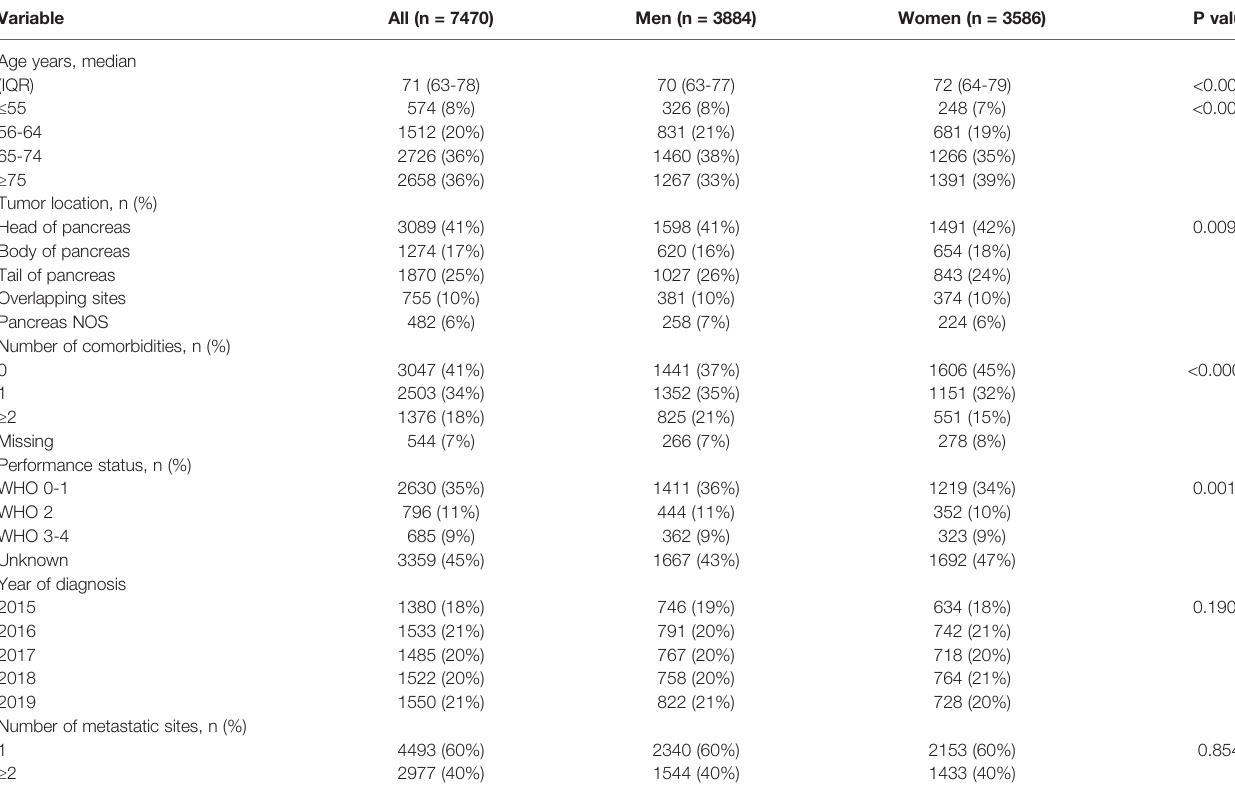
TABLE 1 | Baseline characteristics of 7470 patients with metastatic pancreatic cancer strati fi ed by